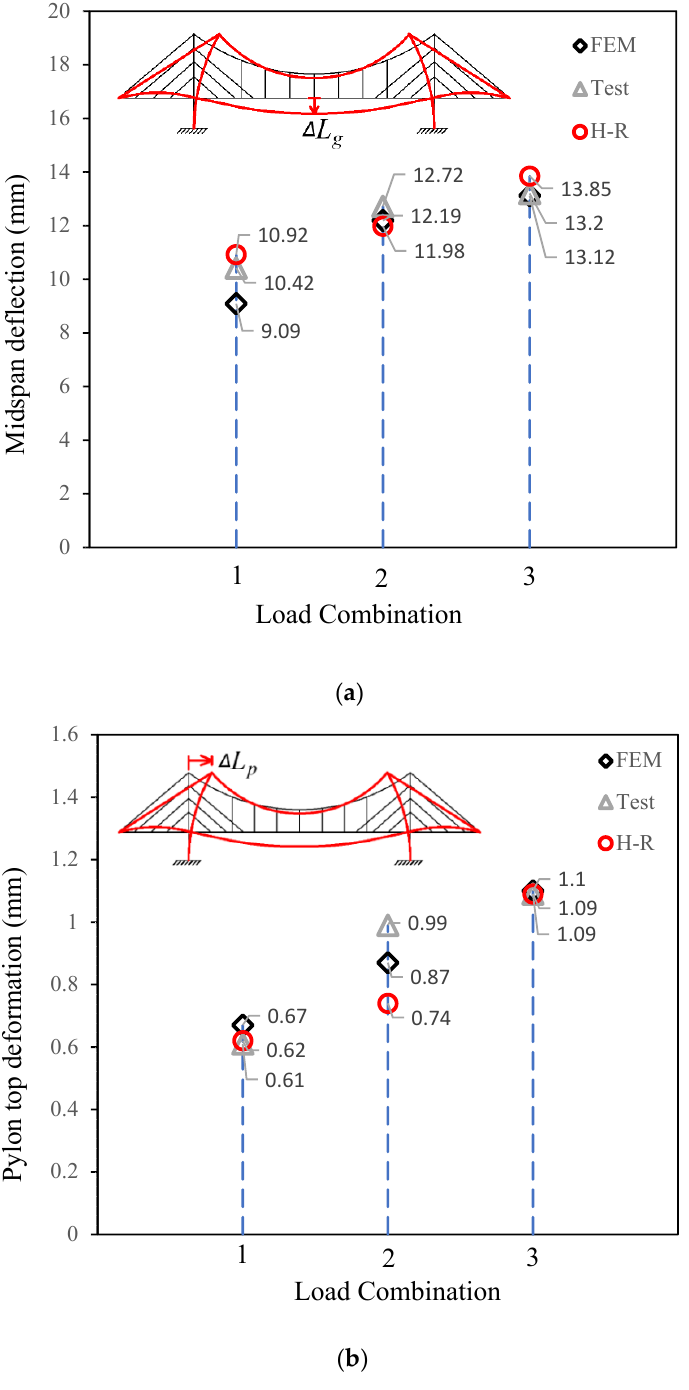
Figure 8. Comparisons between different methods. ( a ) Comparison of midspan deflections. ( b ) Comparison of the pylon top deformation.